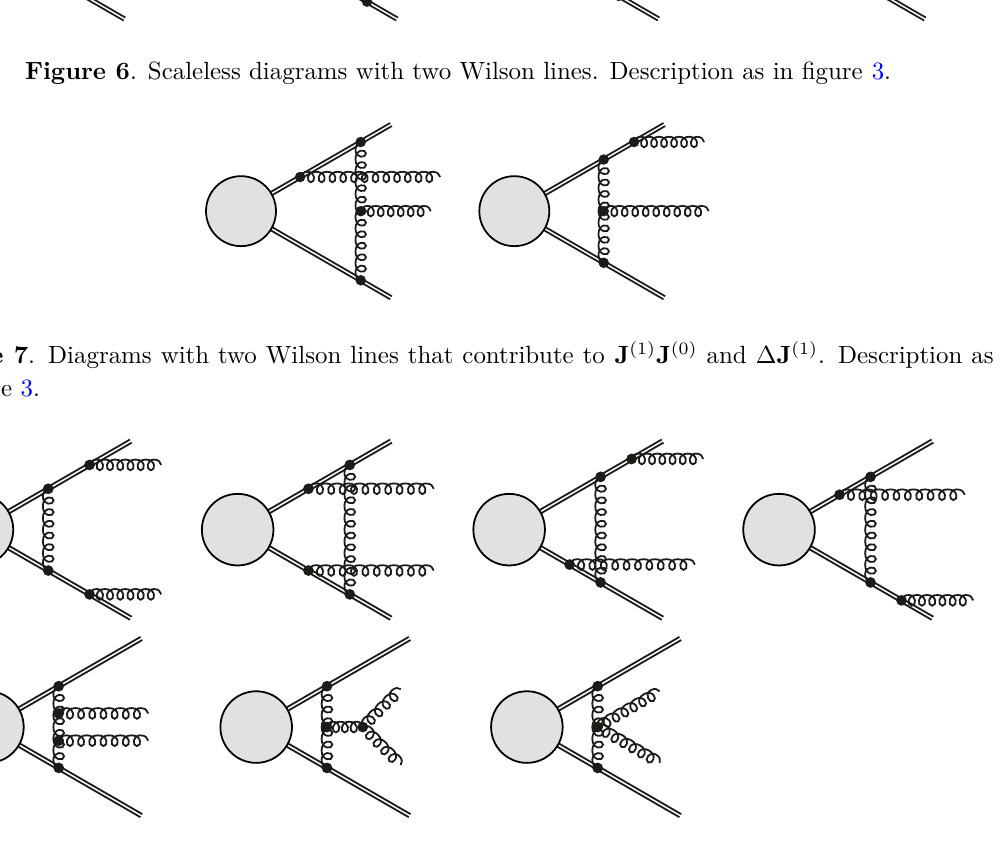
Figure 8 . Remaining diagrams with two Wilson lines that only contribute to ∆ J (1) . Description as in figure